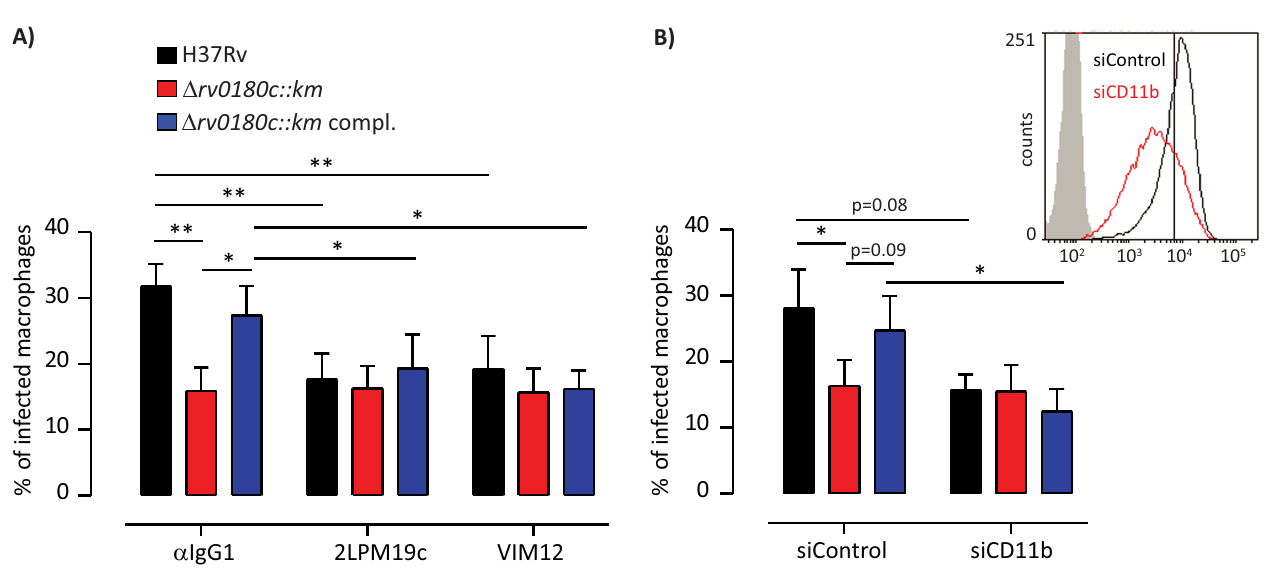
Fig 5. The rv0180c gene allows invasion of hMDMs via CR3. (A) hMDMs were pretreated for 30 min with 10 μ g.ml -1 mAb directed against the I-domain (clone 2LPM19c) or the lectin-site (clone VIM12) of human CR3, or normal mouse IgG1 used as control or (B) hMDMs were transfected with non-targeting control siRNA or CD11b-targeting siRNA. Insert showed cytofluorimetric analysis of membrane expression of CD11b from a representative CD11b silencing experiment in hMDMs. (A,B) hMDMs were then incubated with either the parental H37Rv, the Δ rv0180c :: km mutant, or the Δ rv0180c :: km complemented strains at MOI 10:1 for 60 min at 37˚C, fixed and prepared for analysis by confocal fluorescence microscopy. Vertical bar plots represented the percentage of infected cells. The values are means +/- SEM calculated from 4 (A) and 3 (B) donors. The significance of difference between strains was evaluated using the one- way ANOVA followed by Bonferroni’s post hoc test. The significance of difference between control and treatment was determined using the paired Student’s t- test; � p < 0,05, �� p < 0,01.